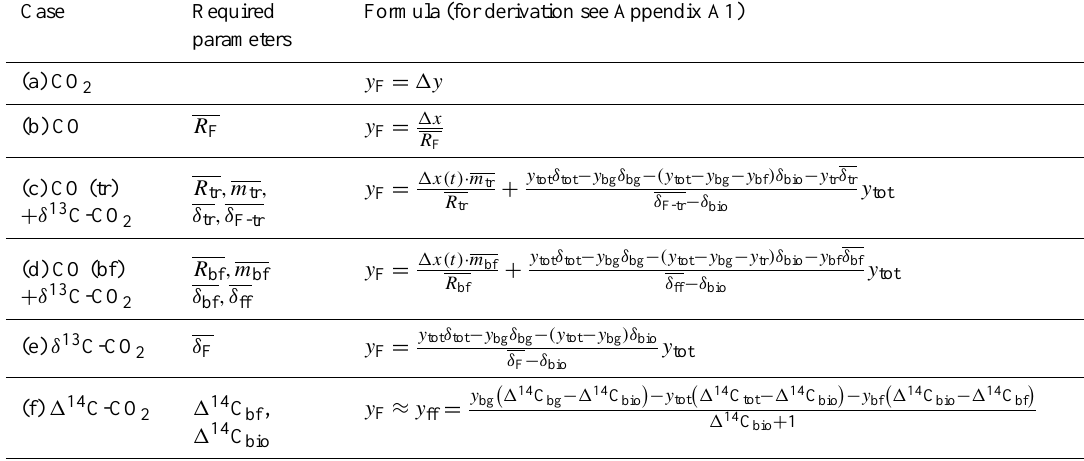
Table 2. Tracer or tracer combinations, required parameters and formula for estimation of targeted fuel CO 2 concentration. In cases (c) and (d) we further divide fuel CO 2 into traffic CO 2 and non-traffic CO 2 , or fossil fuel CO 2 and biofuel CO 2 , respectively. In case (f) we can only estimate fossil fuel CO 2 with (cid:49) 14 C(CO 2 ) and therefore lack biofuel CO 2 for a comprehensive fuel CO 2